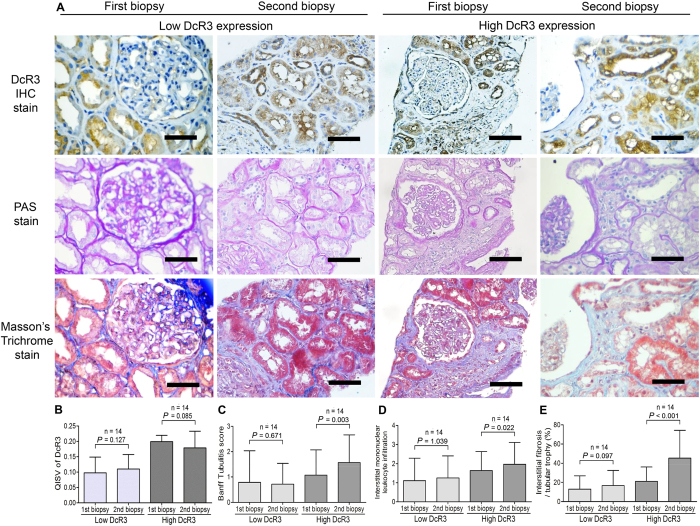
Representative photographs and quantitative values of repetitive biopsy data of immunohistochemical (IHC) staining of DcR3, periodic acid-Schiff (PAS), and Masson’s trichrome staining in kidney allograft rejection.(A) The IHC staining of DcR3, PAS, and Masson’s trichrome staining. (B) In repetitive biopsies, the QISV of DcR3 in the HDE group maintained a significantly higher level than that in the LDE group. (C) Tubulitis significantly increased in the HDE group in repetitive biopsies (P = 0.003). (D) Interstitial mononuclear leukocyte infiltration significantly increased in the HDE group in repetitive biopsies (P = 0.022). (E) The interstitial fibrosis and tubular atrophy scores were compared in the repetitive biopsies in the LDE (P = 0.097) and HDE groups (P < 0.001). There was no difference in time-dependent effect between the 1st and 2nd biopsies in the LDE and HDE groups. Scale bar: 50 μm.